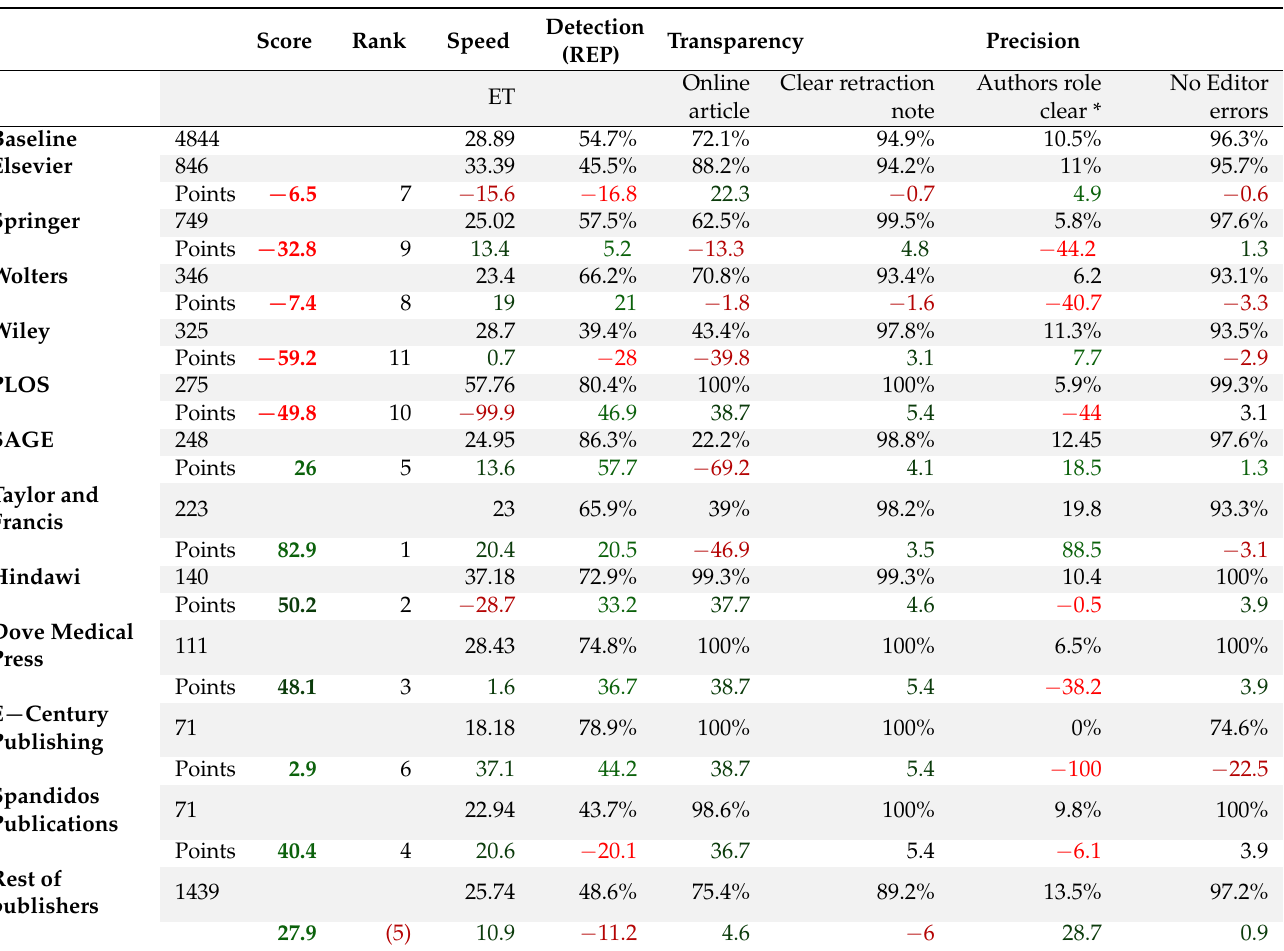
Table 12. SDTP scores and rank for the period 2009–2020 (n = 4844). * Calculated for 4427 articles with more than one author and no editorial errors as retraction